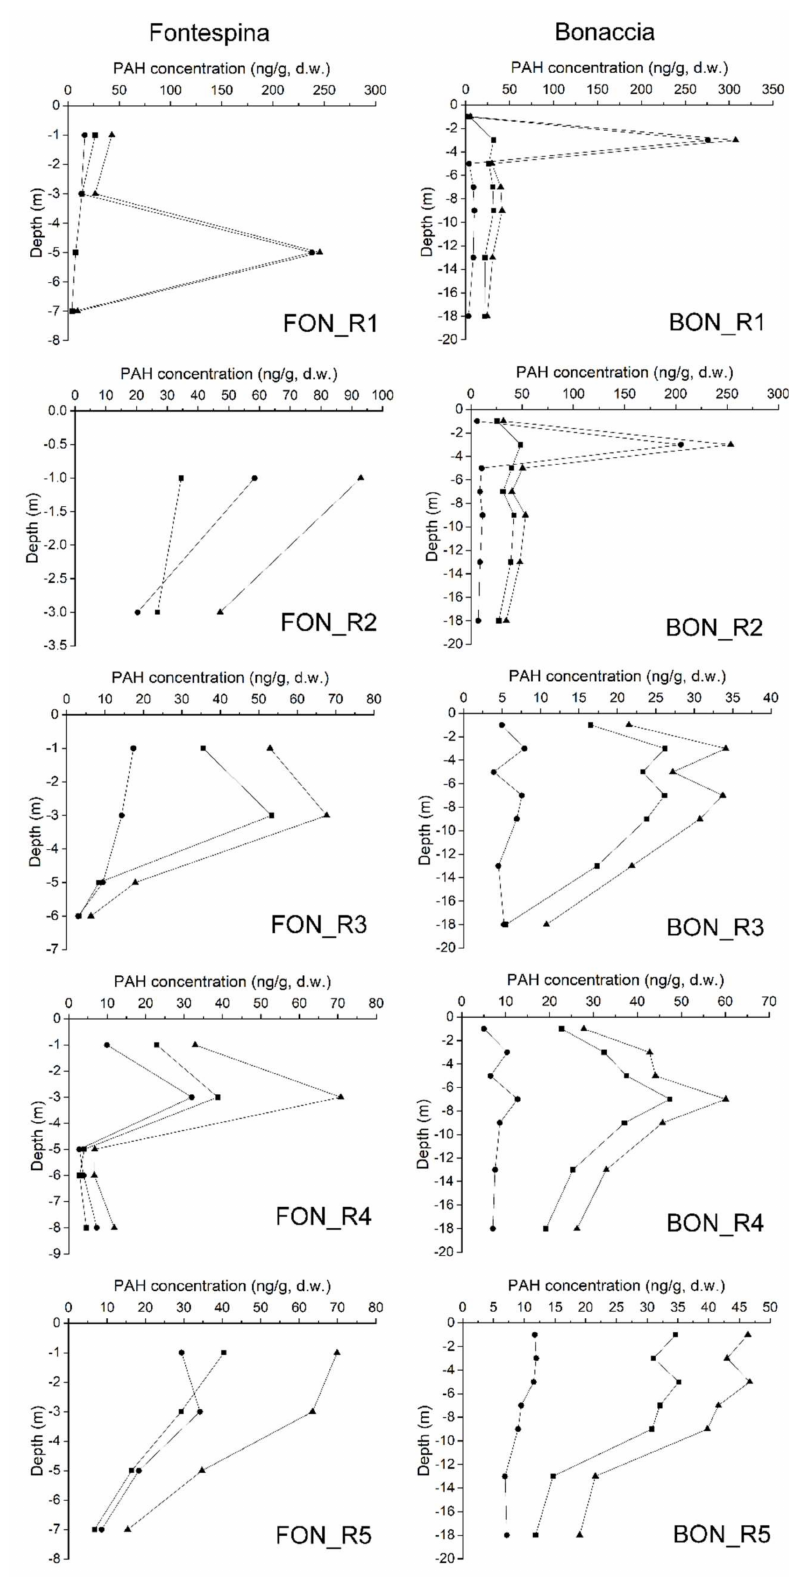
Figure 9. Total PAH concentrations ( (cid:78) ), PAHs with low molecular weight, LMW ( • ) and PAHs with high molecular weight, HMW ( (cid:4) ) recorded in the sediment layer of the Fontespina and Bonaccia